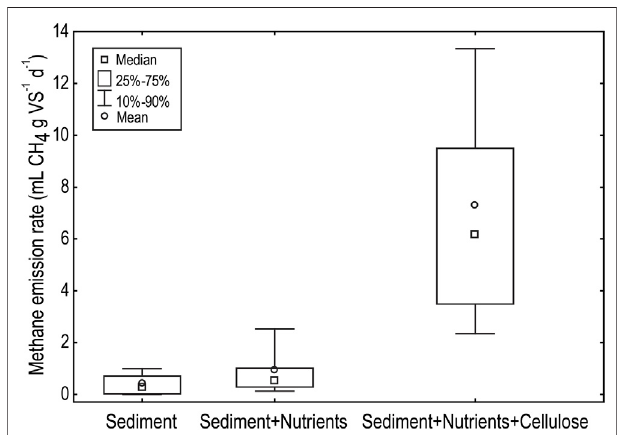
FIGURE 2 | Biological methane potential of sediments from Little Nerang Dam and Lake Wivenhoe when incubated in reservoir bottom waters (Sediment), BMP media (Sediment + Nutrients) or BMP media supplemented with the organic carbon, cellulose (Sediment + Nutrients + Cellulose).